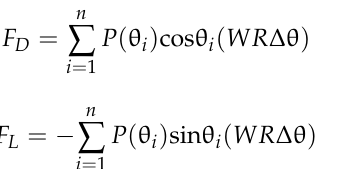
Figure 6. Distribution of pressure coefficients on the centerline of the circular dam for the valida- tion case (Case A1). ( a ) Total pressure; ( b ) dynamic pressure.